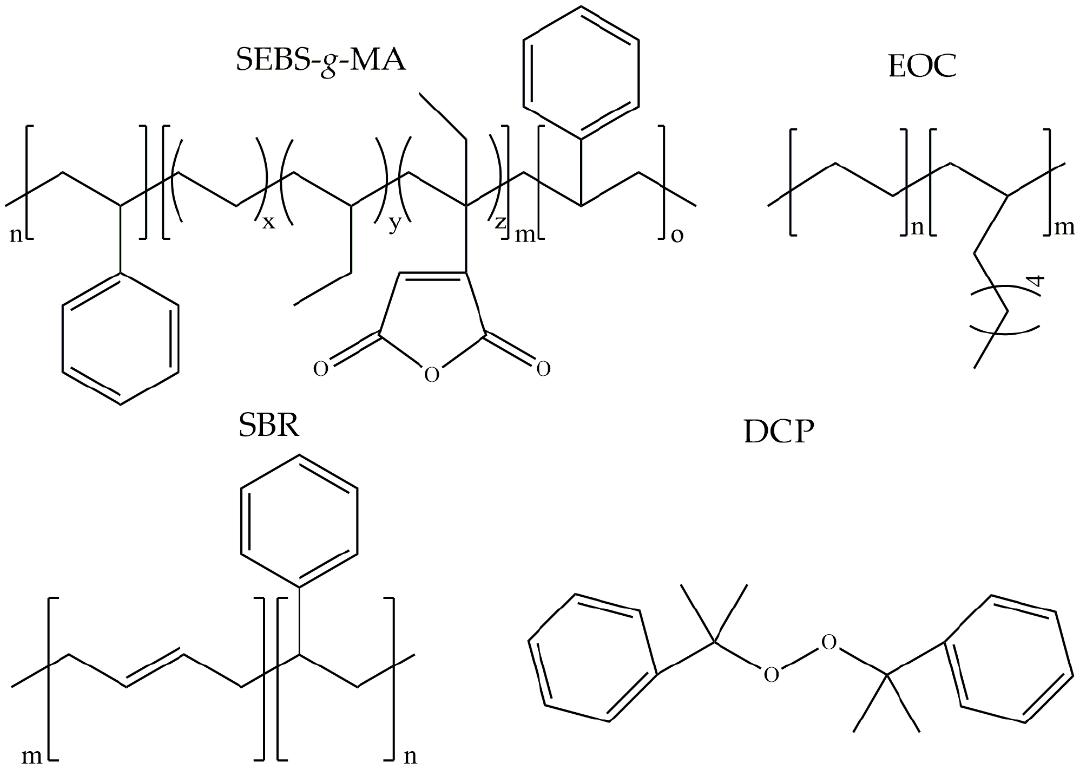
Figure 1. Structural formulas of components used in the study.